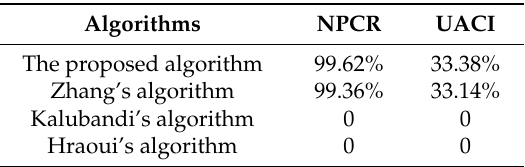
Table 4. Number of Pixels Change Rate (NPCR) and Unified Average Changing Intensity (UACI) results for Figure